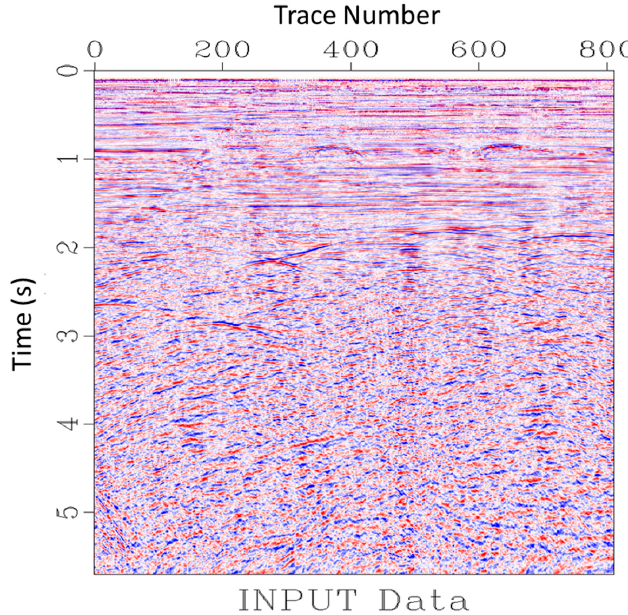
Figure 12. Input real seismic data from the Malaysian Basin, processed with careful diffraction processing and stacked before migration: Sarawak Basin, carbonate build-up structure.